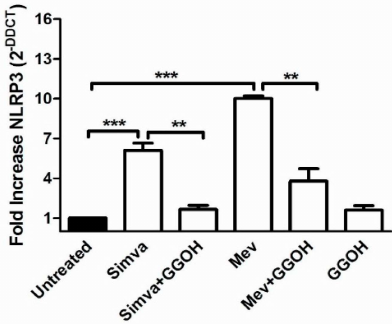
Figure 5. NLRP3 gene expression levels of Daoy cells after different drug treatments were calculated with respect to the untreated condition using the ∆∆ Ct method. All data represent the results of three independent experiments and are expressed as the mean of 2 ´ ∆∆ Ct ˘ standard error (SE). β -Actin was used for the normalization of all Ct values. Data analyses were performed with one-way ANOVA and Bonferroni post-test; ** p < 0.01, *** p < 0.001 versus